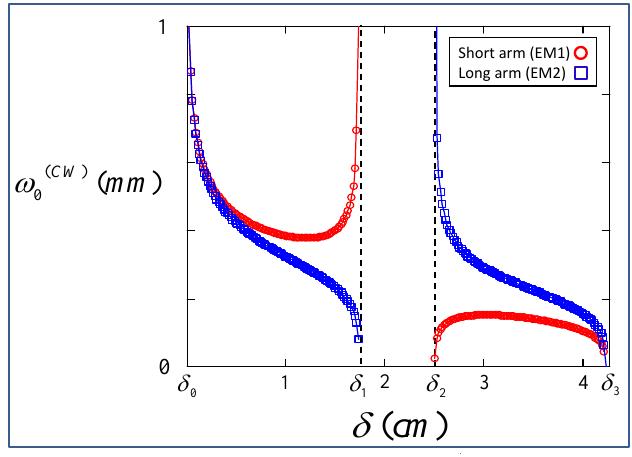
= f = 7.5 cm and arm lengths of L = 30 cm (short 1 2 1 , the beam is collimated in the short arm and focused 1 2